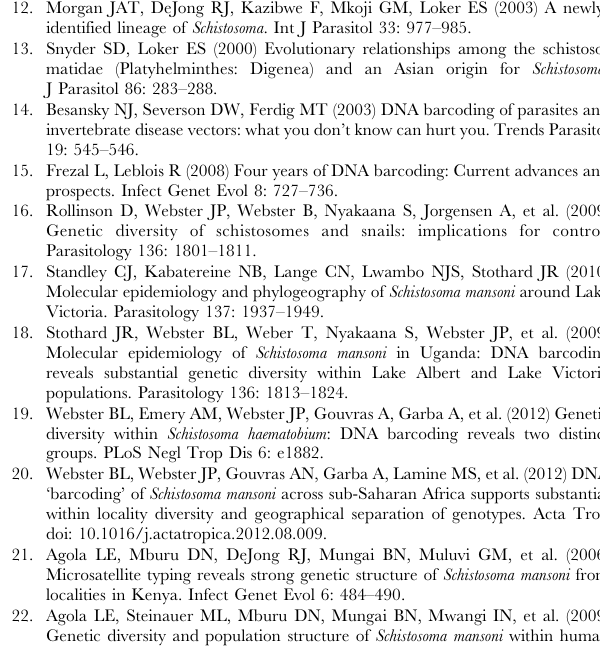
Table S1 Cox 1 diversity stratified by individual host. Table S2 Cox 1 diversity in infrapopulations summa- rised by host type, lake system and survey timepoint. Table S3 AMOVA results showing little evidence of genetic differentiation between villages at Lake Albert or Lake Victoria at